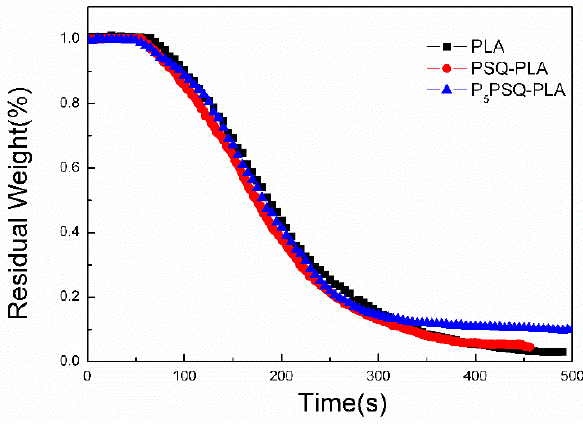
Figure 6. Residual mass rate versus time curves of PLA and its flame retardant composites.